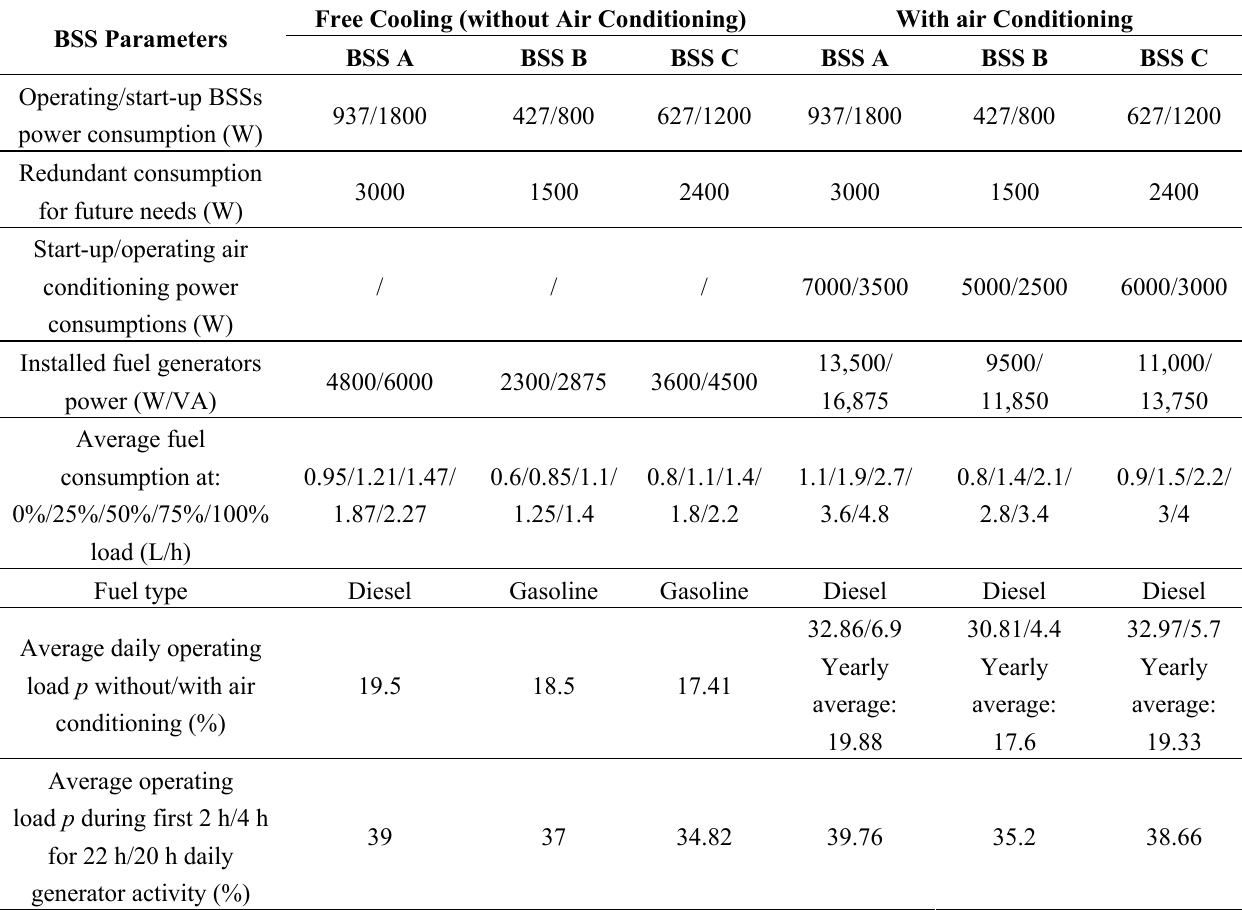
Table 4. Parameters of power consumption and power generation system of the BSSs with temperature regulation based on free cooling and air